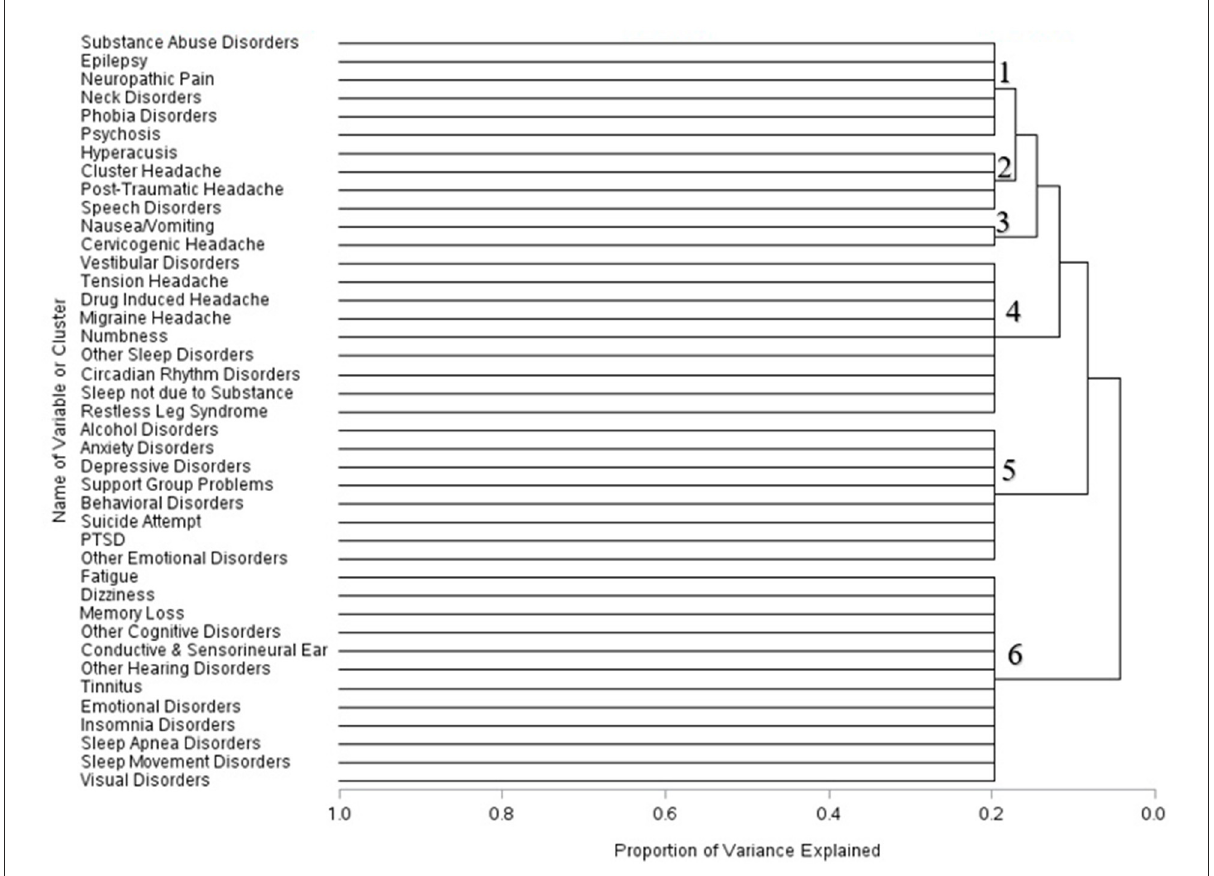
FIGURE1 Dendrogram of condition clusters among mTBI patients one